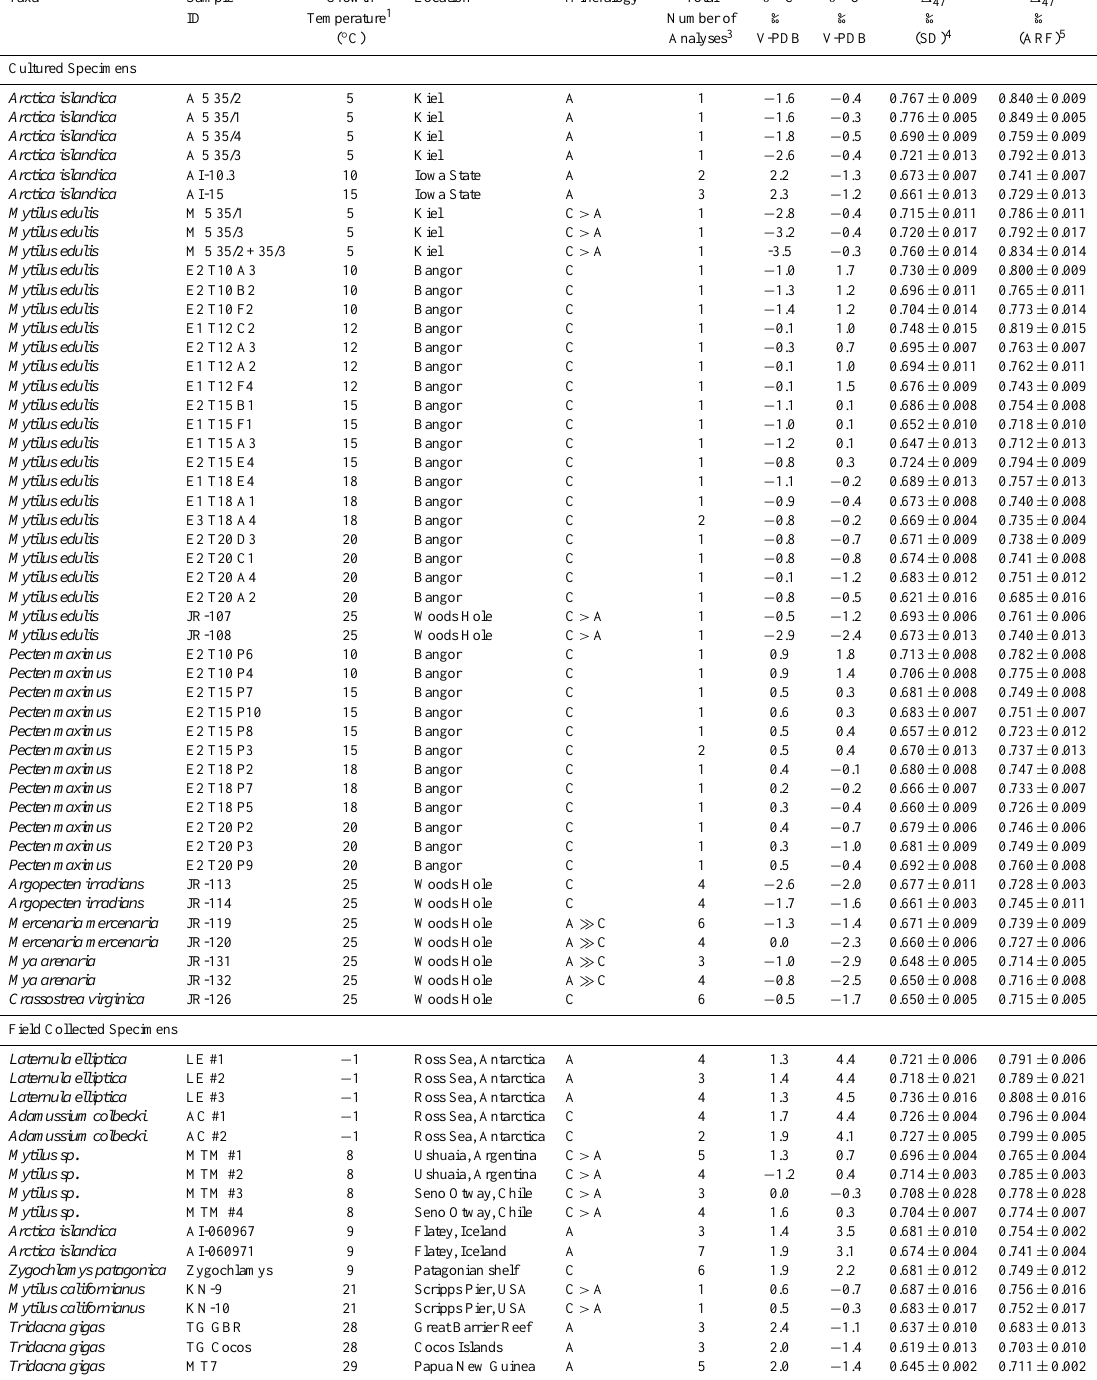
Table 3. Stable isotope data for individual mollusk specimens grown at ambient carbonate saturation state and with no cleaning.